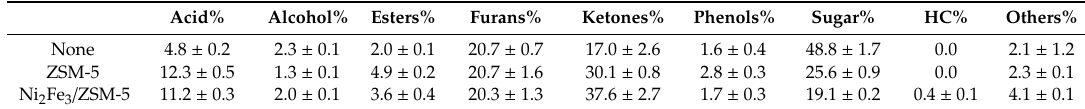
Table 2. Composition of cellulose pyrolyzed products with di ff erent catalysts (peak area% of identified peaks, unidentifiable compounds are lumped together in others category).